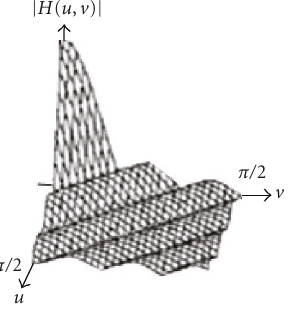
Figure 2: (a) The lake image degraded by linear motion blur using L = 20 pixels, φ = 45 ◦ , (b) Fourier spectrum of